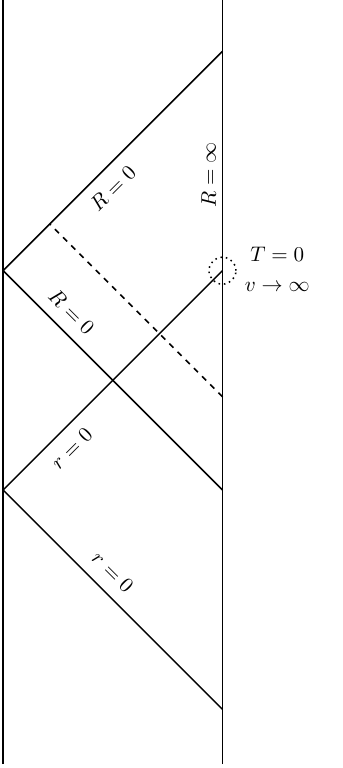
Figure 1 . Penrose diagram illustrating the coordinate transformation (3.3). The coordinates T, R, ϕ cover the upper triangular patch. The coordinates { } patch. The point T = 0, R = dotted circle. The dashed line is an example for a possible initial data